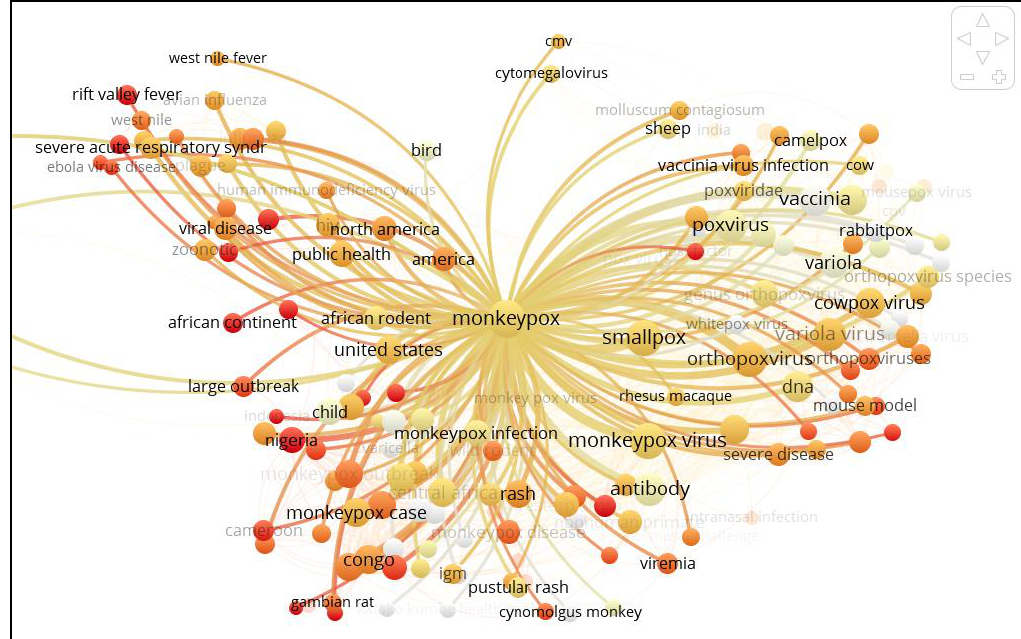
Figure 5b . Visualization of virus, host and its niche (endemic and non-endemic countries).